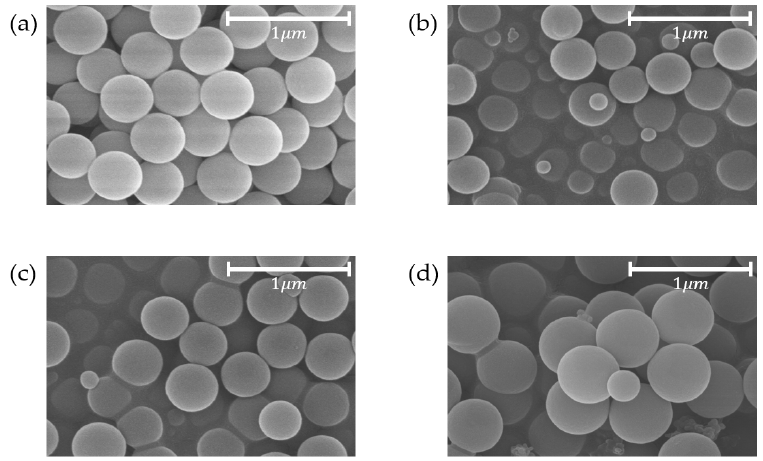
Figure 4. Scanning electron microscopy (SEM) photographs of the silica powders: ( a ) No added phenol-formaldehyde resin (Case 1); ( b ) 0.027 g of added phenol-formaldehyde resin (Case 2); ( c ) 0.030 g of added phenol-formaldehyde resin (Case 3); ( d ) 0.033 g of added phenol-formaldehyde resin (Case 4).